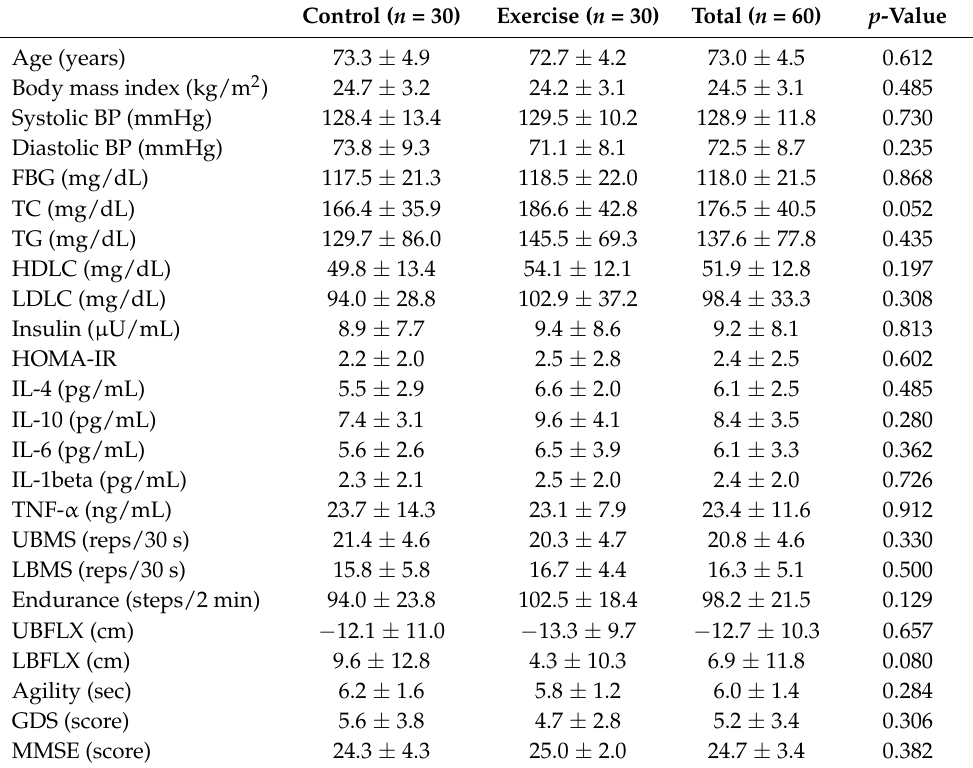
Table 1. Physical characteristics of study participants at